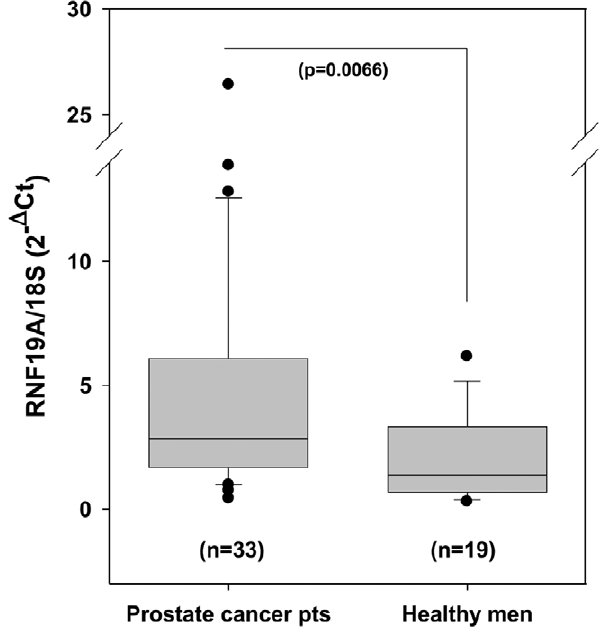
Figure 2. RNF19A transcript levels are higher in prostate cancer patients than in healthy men. Quantitative RT-PCR was performed on whole blood RNA samples from patients with localized prostate cancer (n=33) as well as healthy male controls (n=19). Levels of RNF19A transcript were normalized to 18S RNA (reference gene). Normalized results are presented in box plot format, with boxes representing the 25 th , 50 th , and 75 th percentiles and whiskers represent- ingthe10 th and90 th percentilesofthedata. Outliers are also displayed. The difference between the means was statistically significant (p = 0.0066).